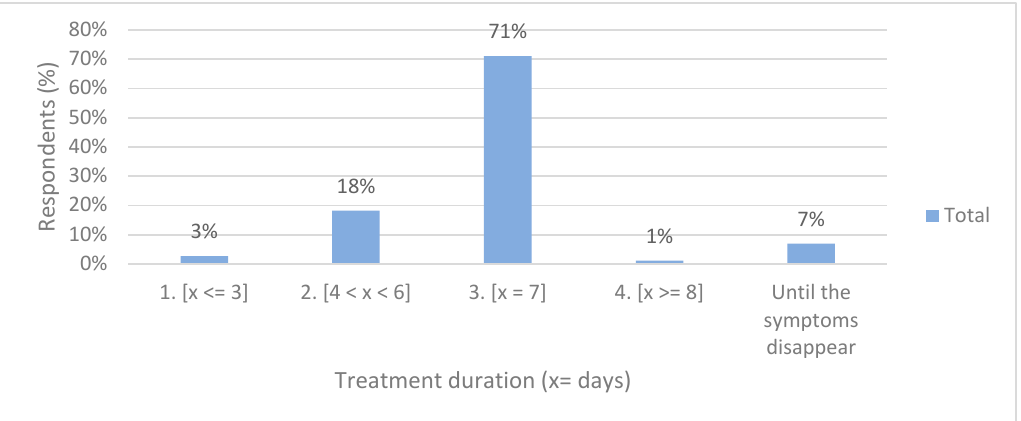
Figure 3. Distribution of responses by treatment duration.